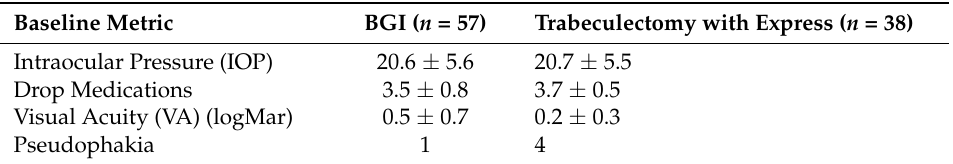
Table 1. Background metrics of patients undergoing Baerveldt 101-350 glaucoma implant (BGI) and